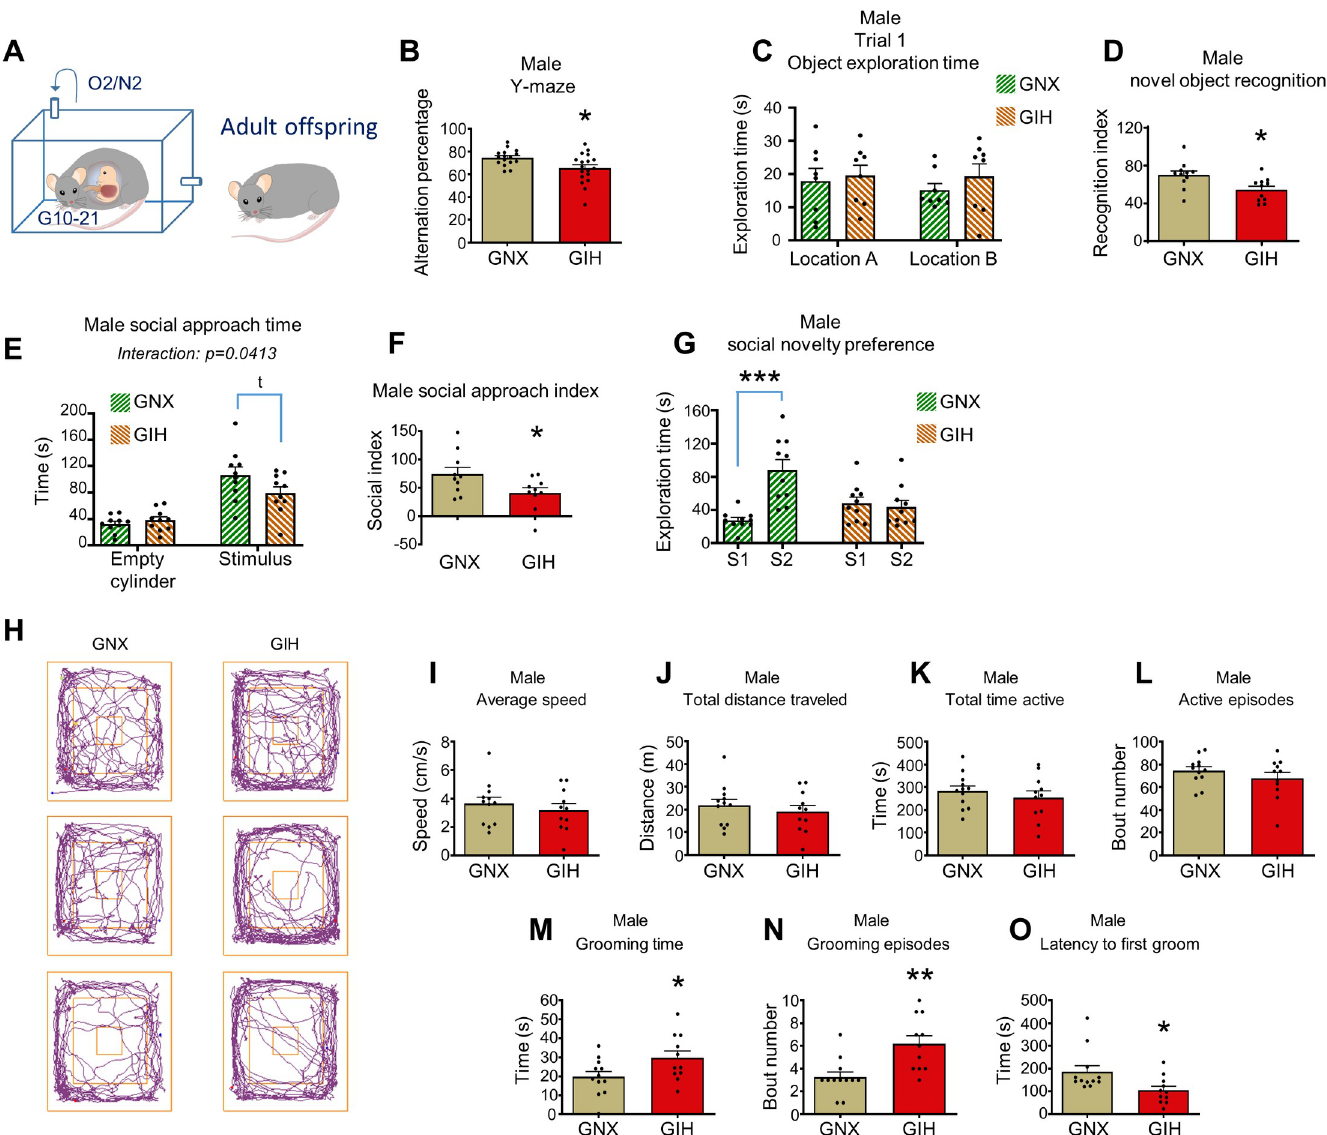
Fig 3. Behavioral phenotypes persist into adulthood in male GIH offspring. (A) Schematic depicting GNX and GIH offspring age pertaining to all data in Fig 3 . (B) Mean Y-maze spontaneous alternation percentage. Adult male GIH offspring show an alternation deficit relative to GNX offspring [t (df,32) = 2.541, p = 0.0137]. n = 17 GNX, 18 GIH rats. (C) Object exploration time during trial 1 of the object recognition test reveals no differences in time investigating either object location in GNX and GIH male offspring [Bonferroni post hoc (df,28), location A p = 1.0; location B p = 0.7534]. n = 8 male GNX, 8 male GIH rats. (D) Assessment of mean novel object recognition index reveals a deficit in adult male GIH offspring [t (df,20) = 2.749, p = 0.0124]. n = 11 male GNX, 11 male GIH rats. (E) Time spent investigating each cylinder in the social approach task for male adults. Direct comparison reveals that GIH offspring spent less time investigating the stimulus rat cylinder than GNX offspring ( p = 0.03); however, this difference did not quite survive multiple comparison [Bonferroni post hoc (df,36) p = 0.06]. n = 10 male GNX, 10 male GIH rats. (F) Social approach index assessment revealed a significant deficit in male GIH offspring [t (df,18) = 2.198, p = 0.0413]. n = 10 male GNX, 10 male GIH rats. (G) Social novelty preference analysis indicates that whereas male GNX offspring exhibited a significant increase in the amount of time spent investigating the novel (S2) versus familiar (S1) rat [Bonferroni post hoc (df,18) p = 0.0005], male GIH rats did not show an increased preference for social novelty [Bonferroni post hoc (df,18) p = 1.0]. n = 10 GNX and 10 GIH rats. (H) Sample locomotor traces in an open field across 10 minutes for male GNX and GIH offspring. Outer, middle, and inner zones of the open field are shown in orange. (I–L) No differences in mean speed in the open field (I), total distance traveled (J), total time active (K), or the number of active episodes (L) were detected between adult male GNX and GIH offspring [(df,21) open field t = 0.7172, p = 0.4811; total distance t = 0.7162, p = 0.4818; total active t = 0.7837, p = 0.4420; active episodes t = 1.071, p = 0.2963]. n = 12 GNX and 11 GIH rats. (M) Adult male GIH offspring showed a significant increase in time spent grooming in the open field compared to GNX offspring [t (df,21) = 2.179, p = 0.0408]. n = 12 GNX and 11 GIH rats. (N) Adult male GIH offspring showed a significant increase in the number of grooming episodes in the open field versus GNX offspring [t (df,21) = 3.473, p = 0.0022]. n = 12 GNX and 11 GIH rats. (O) Adult male GIH offspring showed a shorter latency to the first grooming episode in the open field as compared to GNX offspring [t (df,21) = 2.502, p = 0.0207]. n = 12 GNX and 11 GIH rats. All bar graphs are the mean + SEM. The data underlying this figure can be found in S1 Raw Data. GIH, gestational intermittent hypoxia; GNX, gestational normoxia; S1, stimulus rat 1; S2, stimulus rat